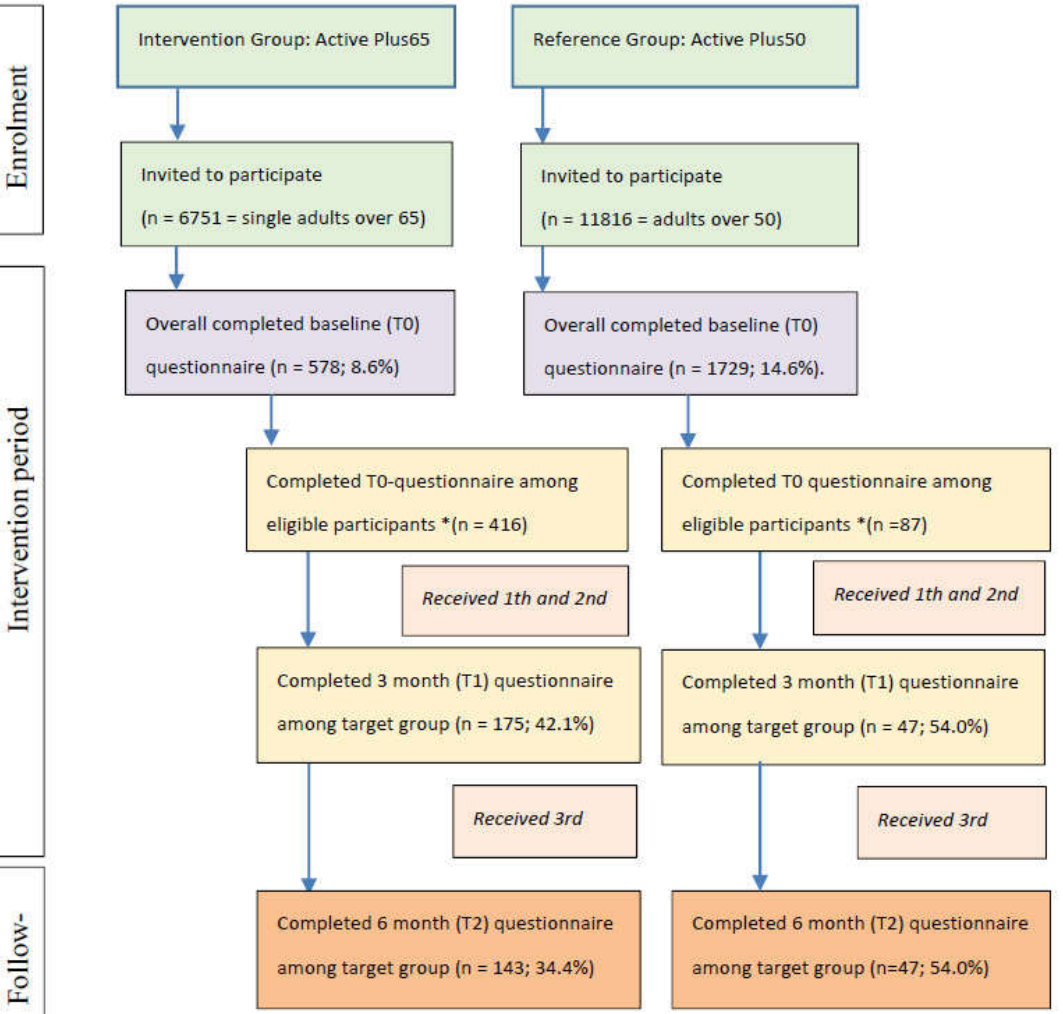
Figure 1. Flow chart of reach and attrition in intervention and reference group (Note: T0 is reported as percentage of invited participants; T1 and T2 are reported as percentage of baseline numbers; * Eligible participants are those that meet all requirements of being single, over the age of 65, and chronically impaired in PA).